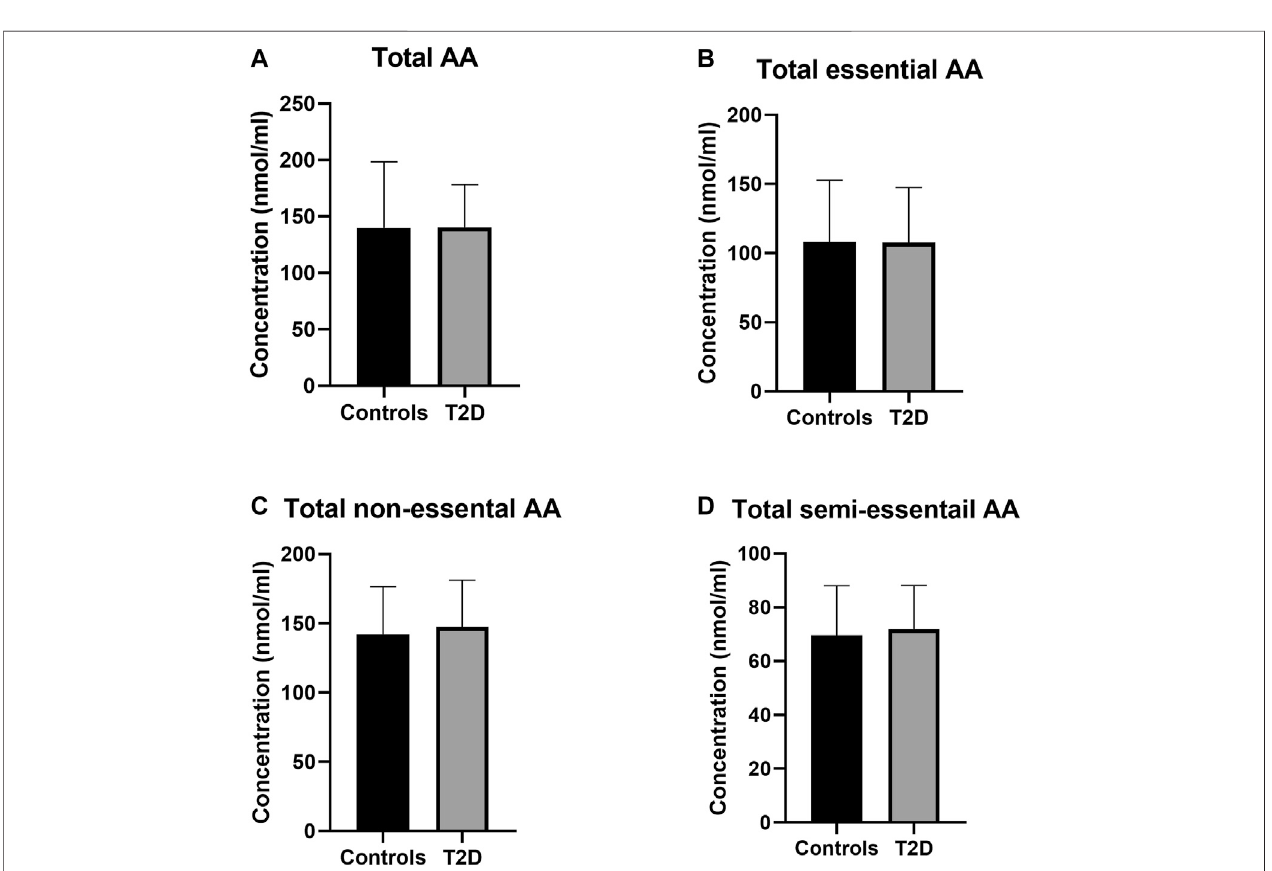
FIGURE 1 | Plasma concentration of total amino acids in type 2 diabetes (T2D). No signi fi cant difference in free plasma concentration of total amino acids (A) , essential amino acids (B) , non-essential amino acids (C) , and semi-essentialamino acids (D) between people with T2D and healthycontrols. Plasma samples from T2D people ( n (cid:2) 124) or healthy controls ( n (cid:2) 67) were prepared and deproteinized before total amino acid pro fi ling was carried out (unpaired independent t -test).